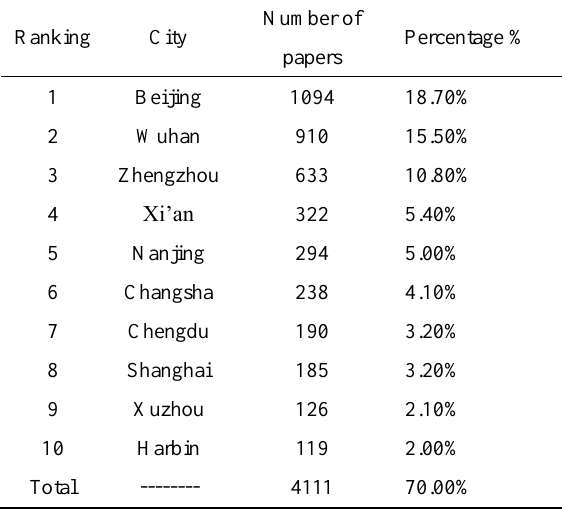
Fig.8 Top 10 cities in the number of paper publishing